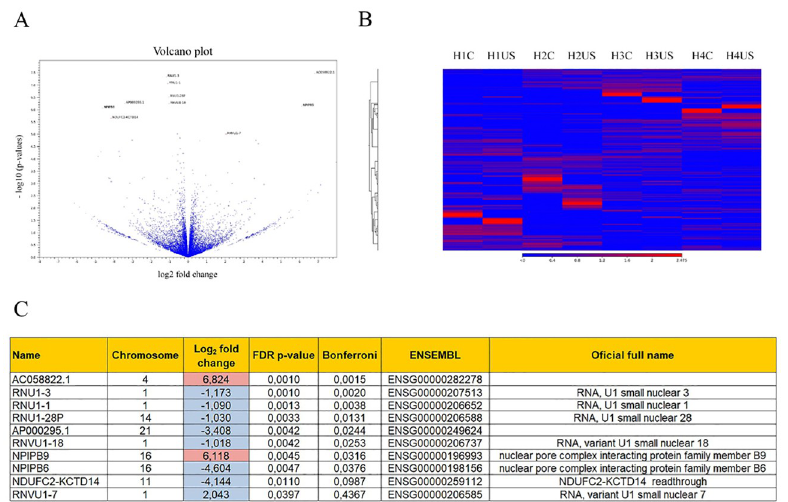
Fig 9. RNA-seq results. (A) Volcano plot showing the 10 genes differentially expressed between control and ultrasound-stimulated (US) human s-MPs. (B) Heat map graph, where the red zones are correlate with upregulated genes and the blue zones with the absence of changes in expression. (C) Differentially expressed genes that fulfill the conditions to present a p-value under 0.05 and fold change over 2 or under -2.